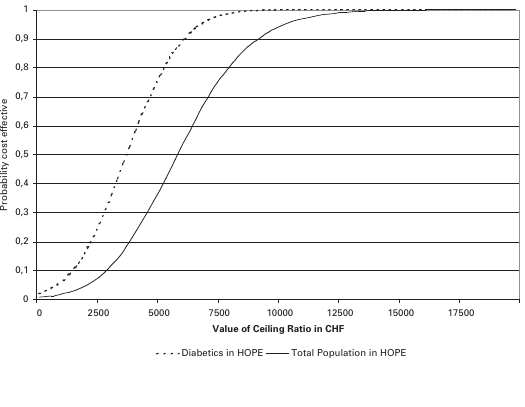
analysis of the price of ramipril and best- case/worst-case sce- nario analysis in the diabetic patient sub- group (discounted with 5% per year). ICER: Incremental cost-effectiveness